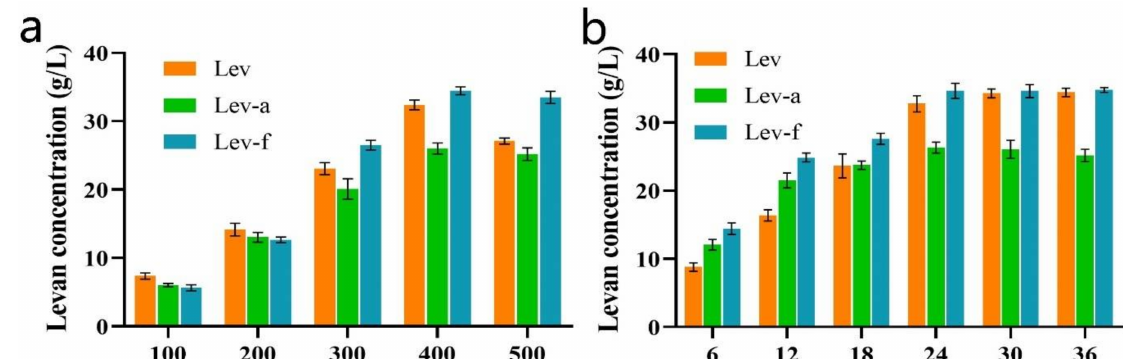
Figure 6. Optimization of sucrose concentration and reaction time on levan synthesis. ( a ) The effect of sucrose concentration on levan synthesis. ( b ) The effect of reaction time on levan synthesis with a sucrose concentration of 400 g/L. Lev, free levansucrase; Lev-a, levansucrase displayed with a-agglutinin; Lev-f, levansucrase displayed with Flo1p.